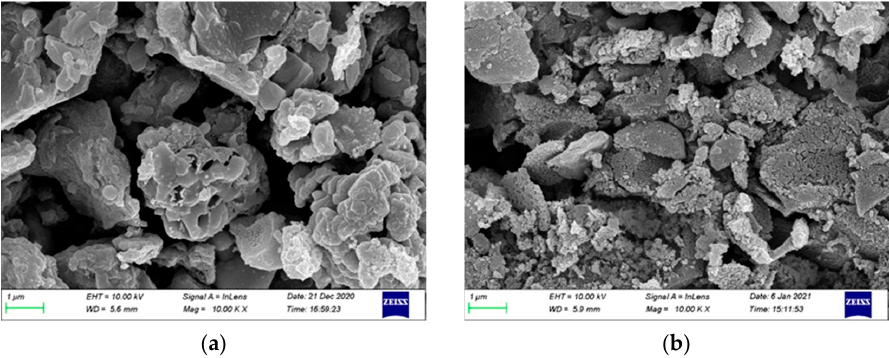
Figure 9. SEM image of activated carbon prepared using a 10% concentration steam activation when adding ( a ) 6% K 2 CO 3 and ( b ) 9% CaCl 2 .